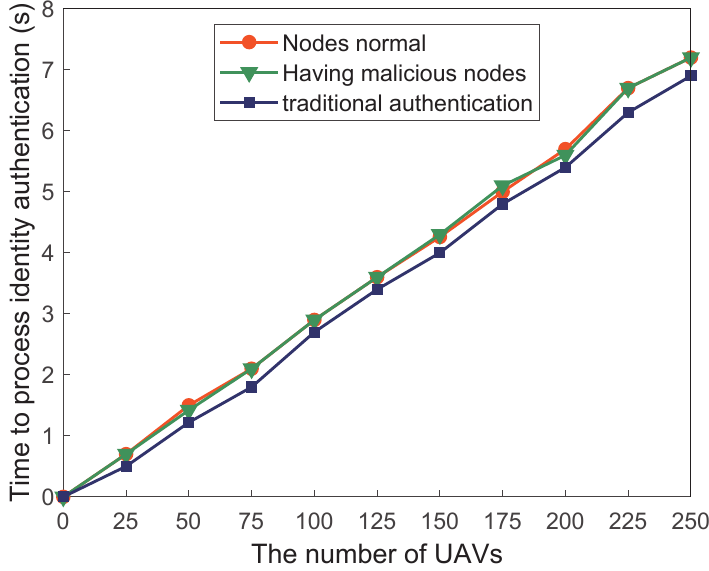
Figure 6. Identity authentication time according to the number of